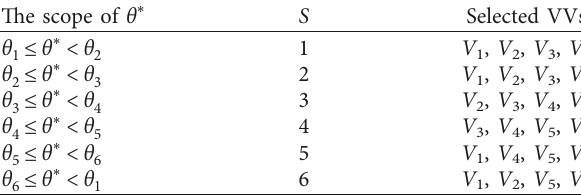
Figure 5: Predicted current error space vector Table 1: Voltage vector selection principle.